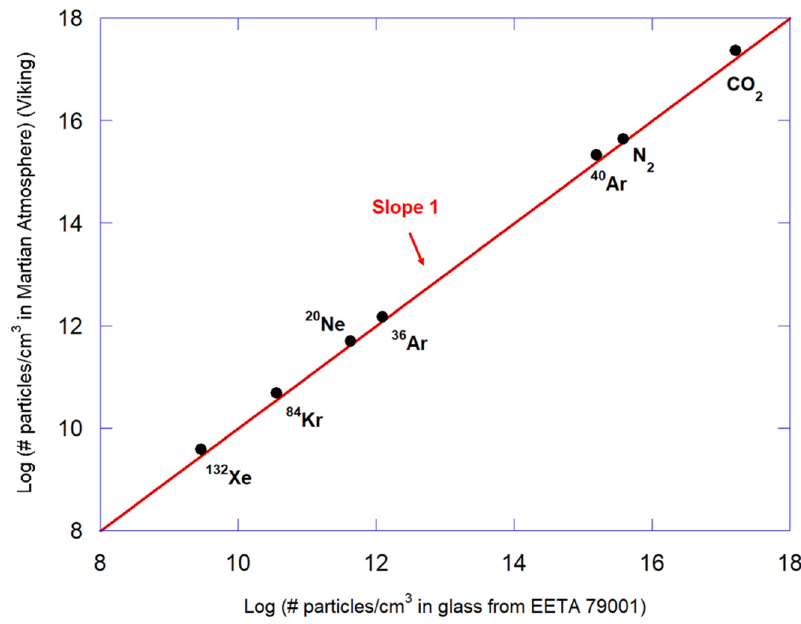
Figure 2. Log–log plot of the volume abundance of gases (number of particles per cubic centimeter) measured by Viking in the Martian atmosphere and in EETA 79001 glass [22].